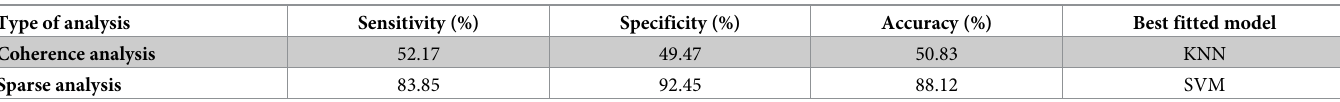
Table 2. Results of application of optimized machine learning approach for the task-related and non-task-related sEMG channels. Type of